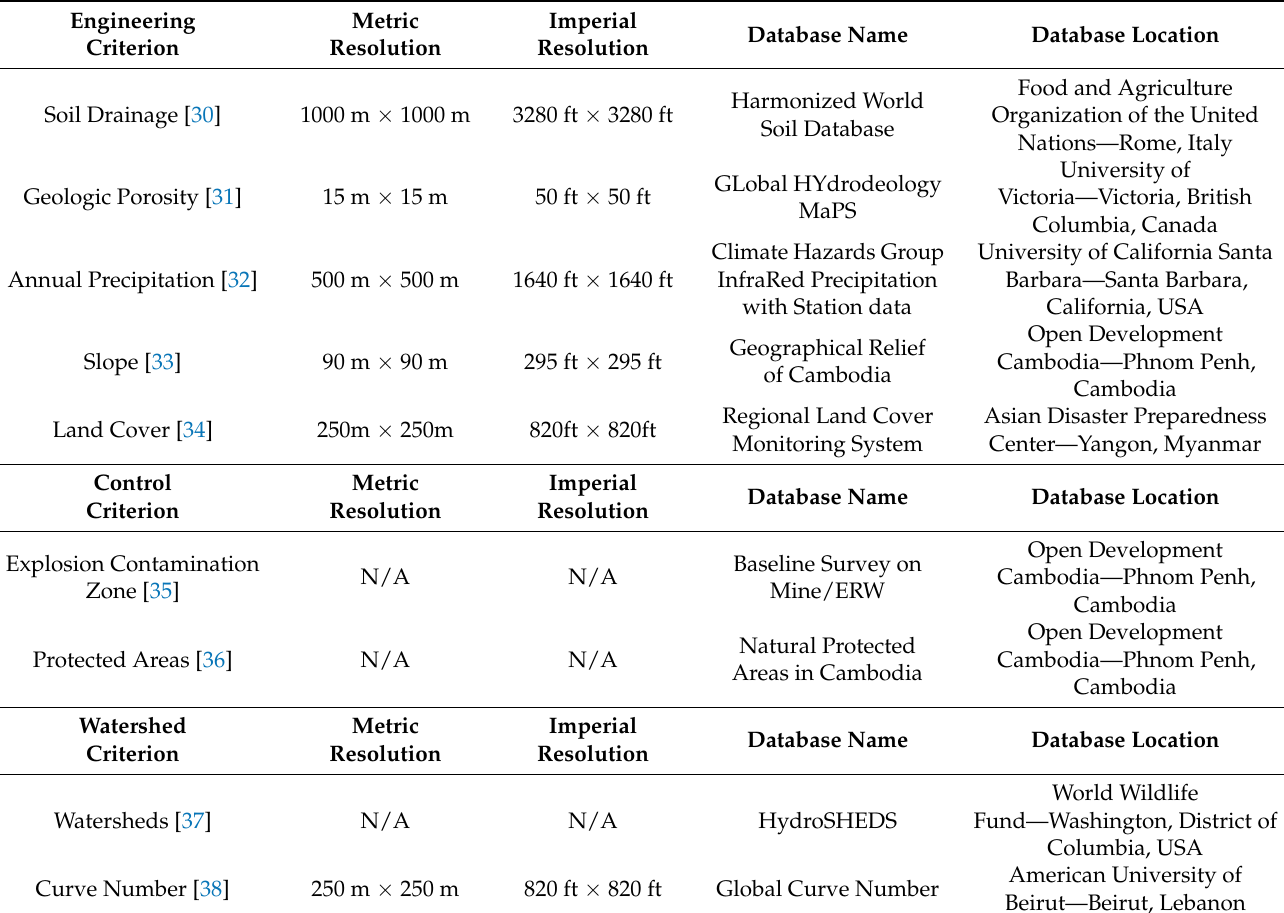
Table 1. Manuscript spatial data resolution and